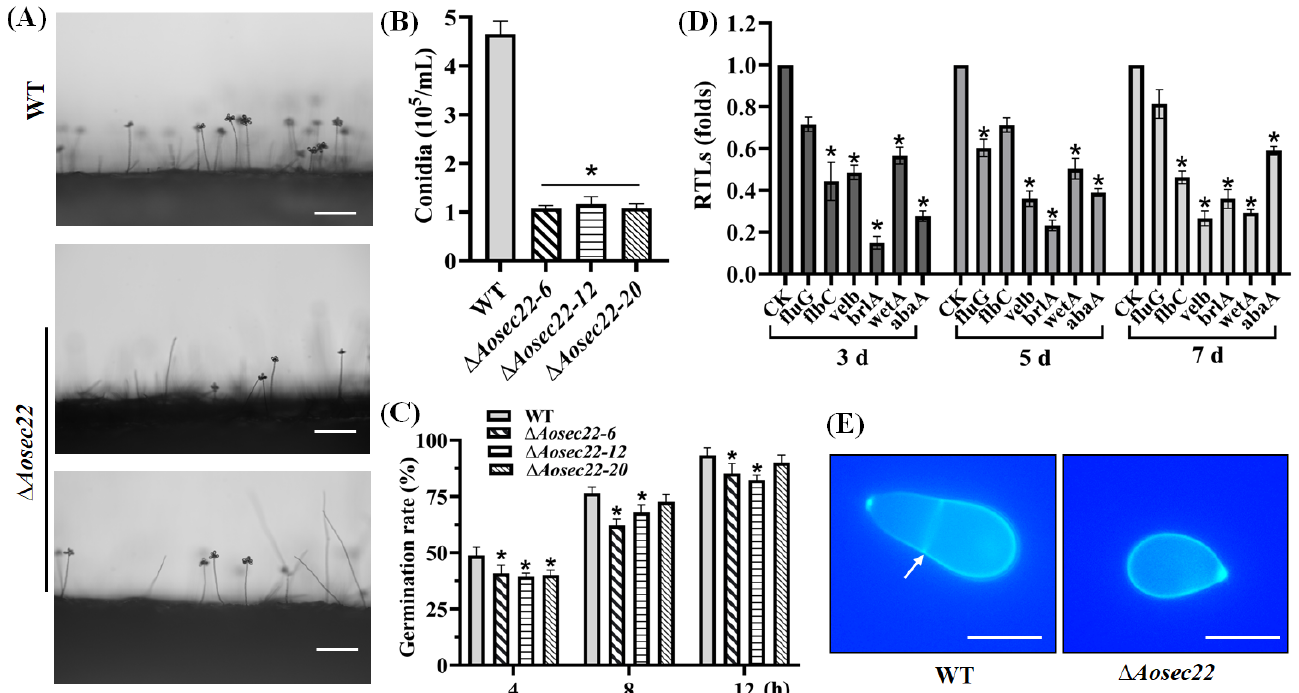
( B ) Diameters of fungal colonies in ( A ). ( C ) Hyphae of the WT and mutant strains stained with calcofluor white (CFW) and 4 (cid:48) ,6-diamidino-2-phenylindole (DAPI) after 7-day incubation on CMY. One hundred hyphal cells were randomly selected for the counts of nuclei. Bar: 10 µ m. ( D , E ) Length of hyphal cells and count of nuclei in ( C ). Measurements represent the average of three independent experiments. The asterisk indicates a significant difference between the mutant and WT strains ( p < 0.05).